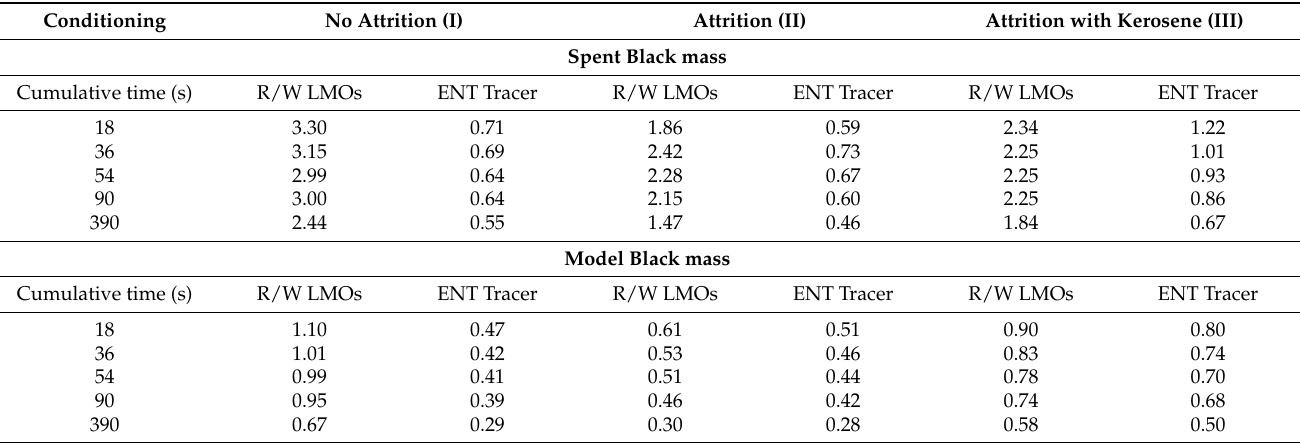
Table 2. Entrainment degree of the tracer particles and the LMO particles for the spent black mass and model black